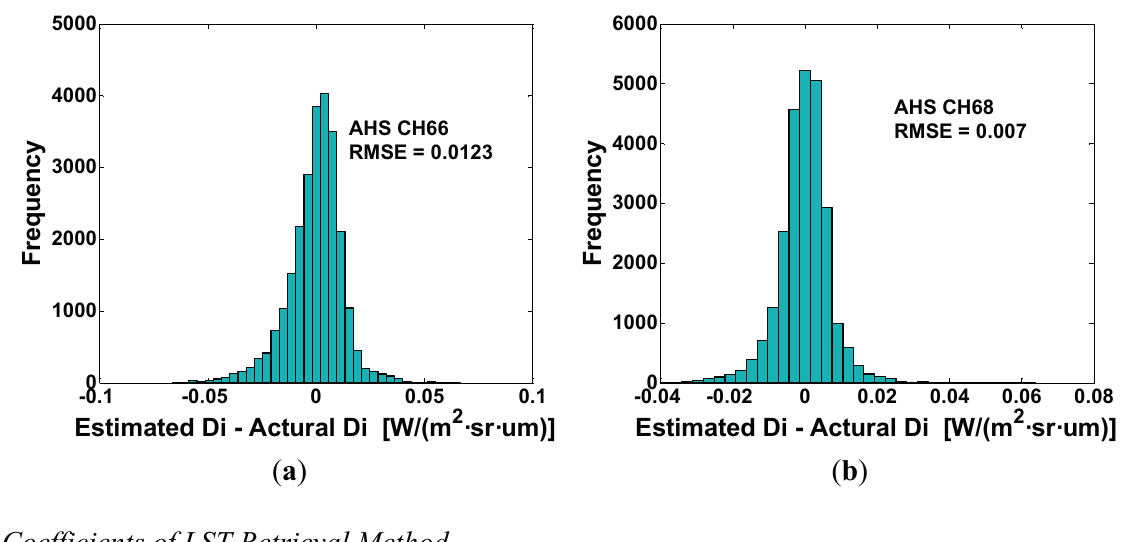
Figure 4. Histogram of the difference between the estimated and actual direct solar radiance ( D i ) for CH66 ( a ) and CH68 ( b